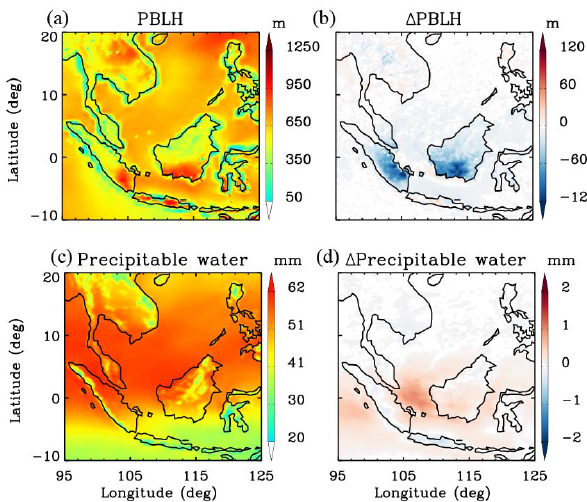
Fig. 3. Distribution of monthly averaged variables in October 2006. (a) Planetary boundary layer height (PBLH) without considering the radiative effect of smoke aerosols, (b) difference of PBLH due to the radiative effect of smoke aerosols. (c) and (d) are respectively same as (a) and (b) but for precipitable water. The OC/BC ratio is 10 in the